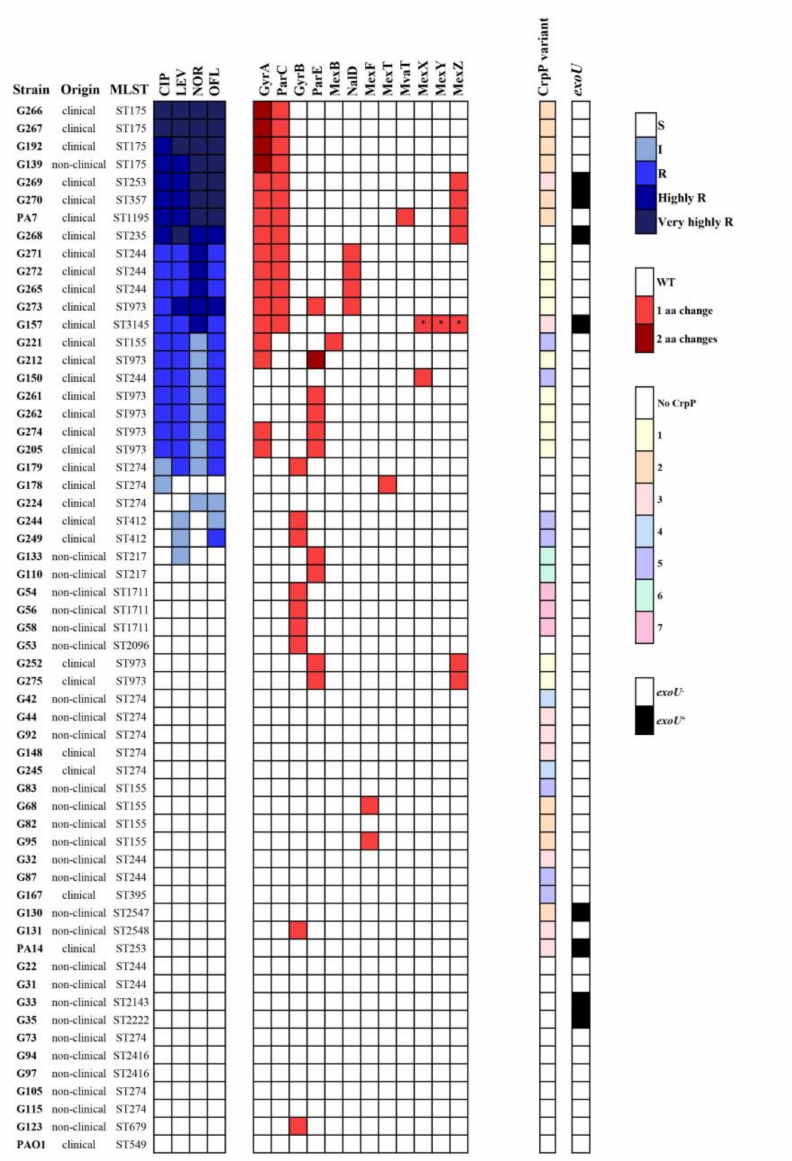
Figure 1. Heatmap Showing Minimum Inhibitory Concentrations (MIC) of Fluoroquinolones (CIP = ciprofloxacin; LEV = levofloxacin; OFL = ofloxacin; NOR = norfloxacin) Where S Corre- sponds to Susceptible, I to Intermediate, R to Resistant until 32mg/L, highly R from >32 to 128mg/L, and very Highly R >128mg/L (levels of resistance according to Clinical and Laboratory Standards Institute, CLSI [13]). The different variants of CrpP are shown in different colors, and the presence of the exoU gene is indicated in black. The fluoroquinolone relevant alterations detected in 12 chromoso- mal proteins are shown in red or maroon colors depending on the number of alterations. P. aeruginosa PA14 is the same as UCBPP-PA14. * Protein not